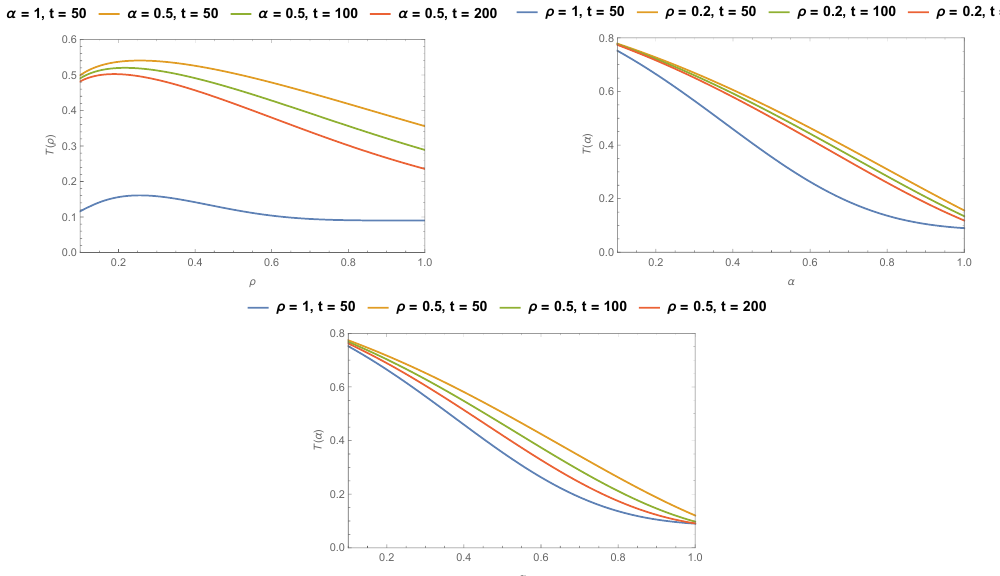
Figure 10. Comparison of drying kinetics with Lewis generalized fractional model under different finite times, different α orders and different ρ values, k αρ = 0.24, Y 0 = 1, Y e =